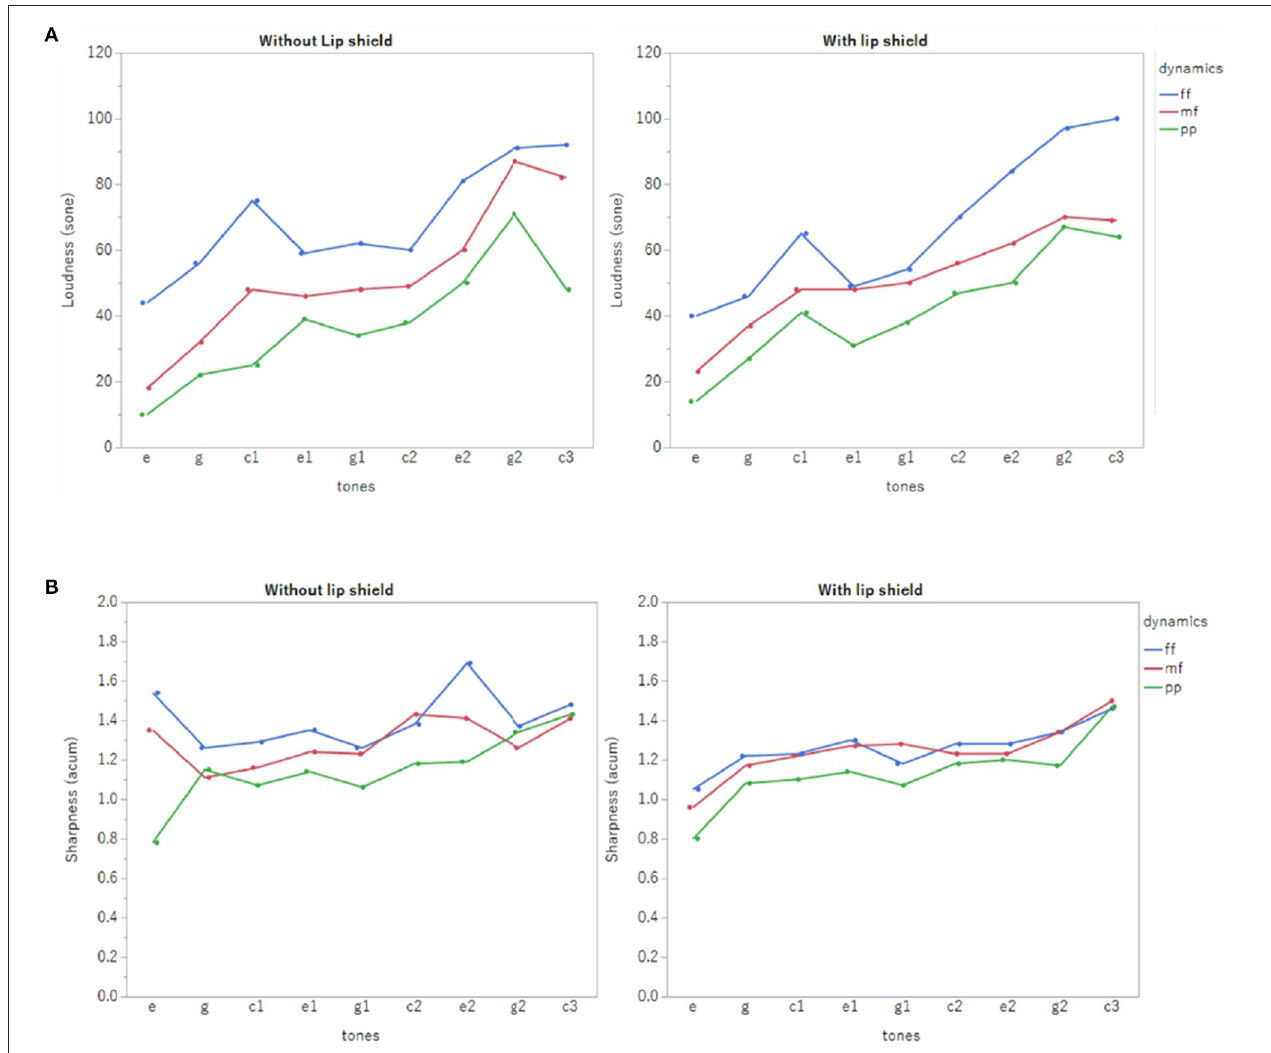
FIGURE 3 | The loudness (A) and sharpness (B) results of the psychoacoustic